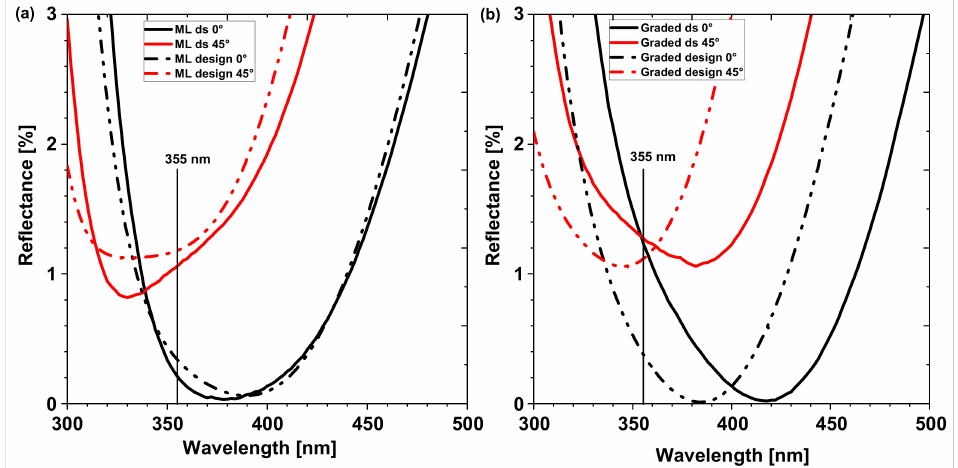
Figure 15. Comparison of designed and measured reflectance spectra for ( a ) multilayer stack and ( b ) graded antireflection coatings at 355 nm wavelength.